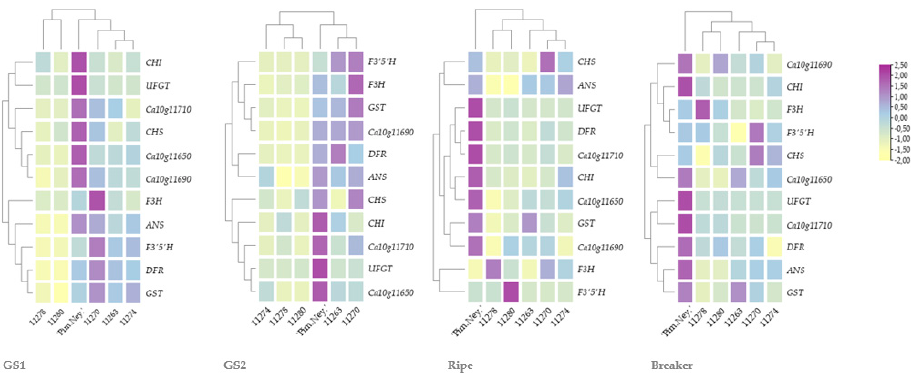
Figure 2. Fold expression pattern of the tested genotypes compared to cv. ‘Soroksári’ in 4 phenophases, pseudo-colour bar is showing the level of fold expression on a normalized scale. Table 6. Log2 fold change of R2R3-MYBs compared to the cv. ‘Soroksári’ and extracts’ colouration throughout the four tested phenophases.